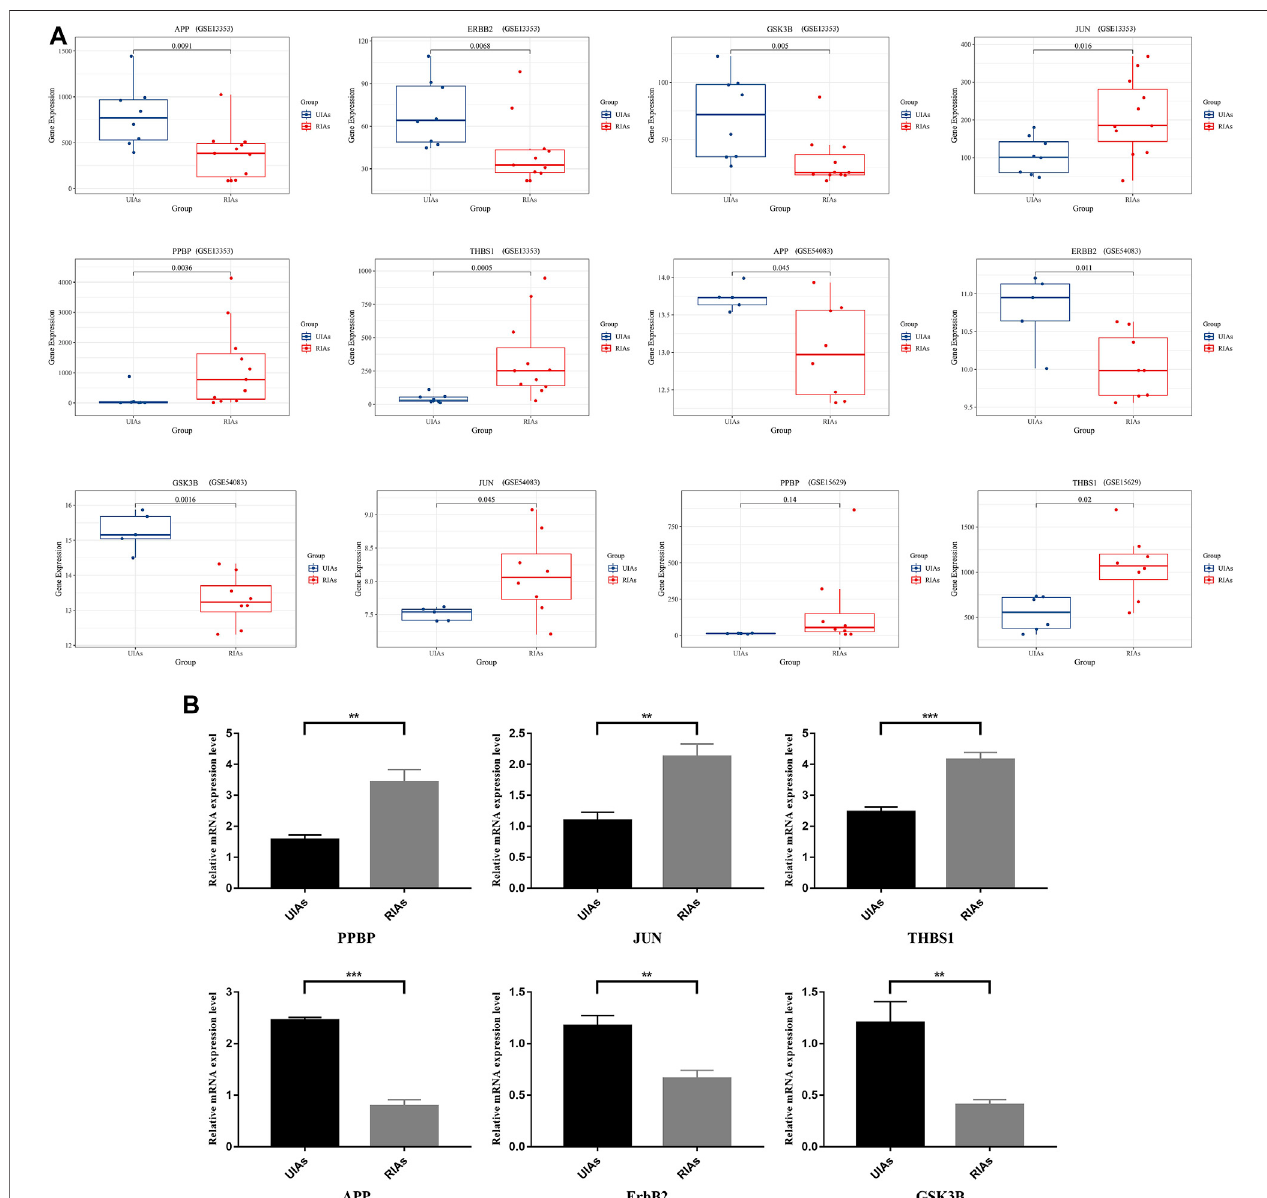
FIGURE 6 | Relative expression level of six hub genes in UIAs and RIAs. (A) The expression level of hub genes in GEO dataset; (B) The mRNA levels of hub genes detected by qRT-PCR. The y -axis represents the relative expression of genes. UIAs: Unruptured Intracranial Aneurysm Samples; RIAs: Ruptured Intracranial Aneurysm Samples. p p -value < 0.05, pp p < 0.01, ppp p < 0.001.